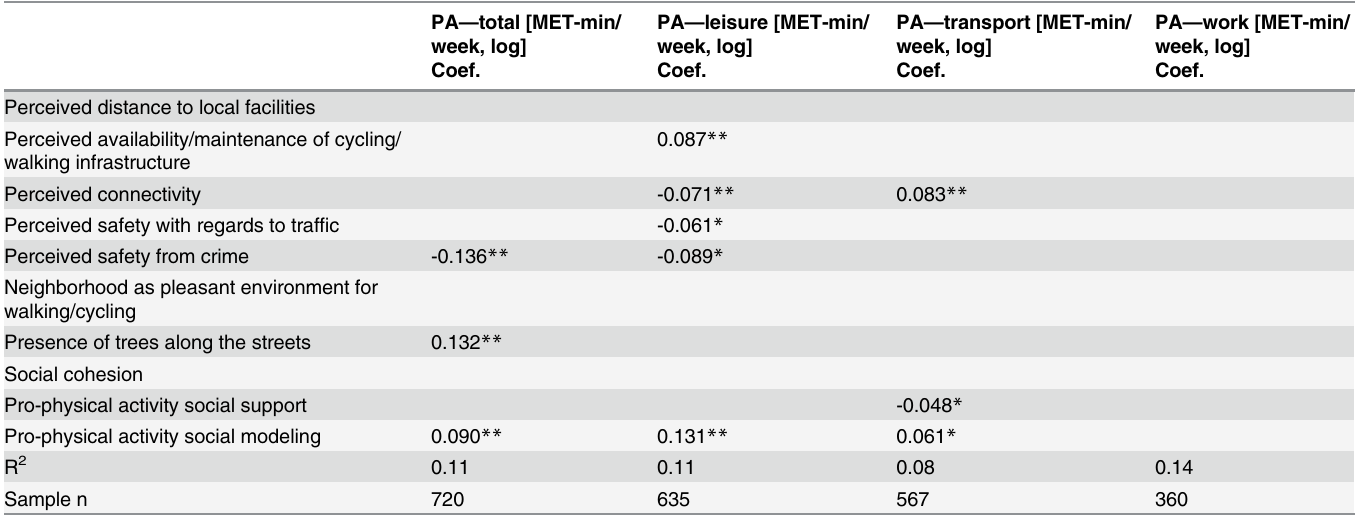
Table 2. Cardiovascular risk factors/behaviors by built and social residential characteristics as well as individual characteristics — final stepwise multiple linear regression model results (1) a .